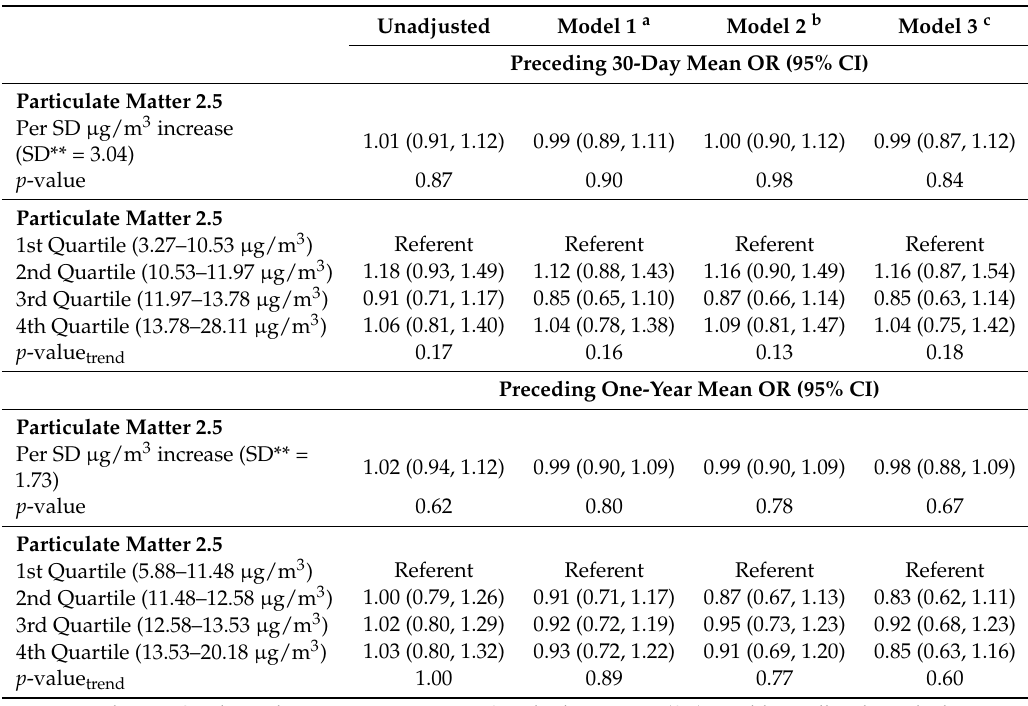
Table A2. Odds ratios * (ORs) and associated 95% confidence intervals (CIs) for the association between the preceding 30-day and one-year mean particulate matter 2.5 and incident respiratory infection related sepsis. Among 776 total